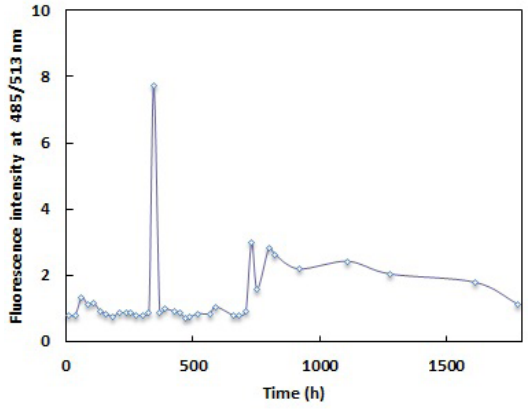
Figure 5: Fluorescence intensity in well S1-5.